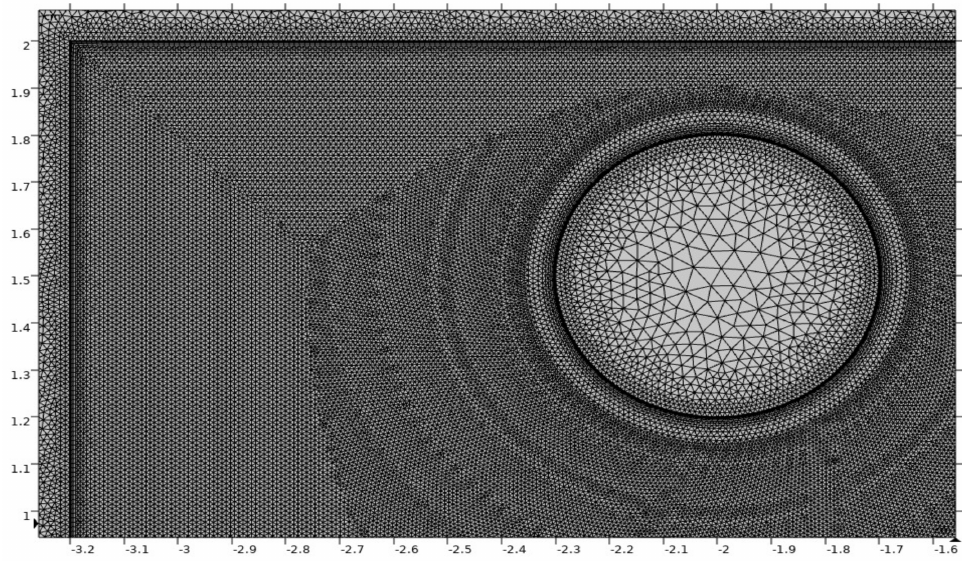
Figure 3. Mesh configurations.